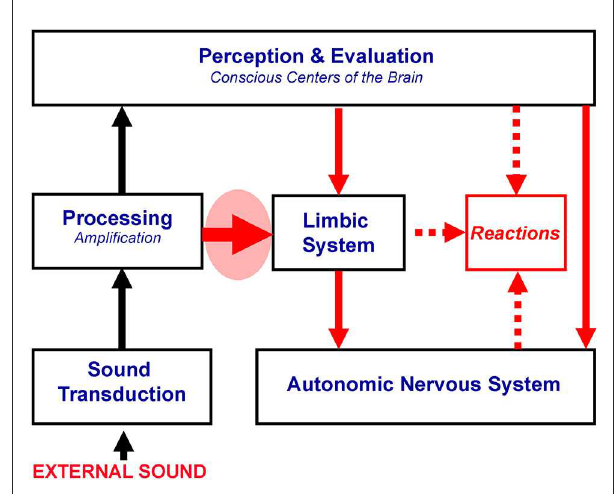
FIGURE2 Proposed mechanisms of misophonia. The thick red arrow in the red oval marks the functional linking of the subconscious part of the auditory system with the limbic and autonomic nervous systems, postulated to be responsible for misophonia. All systems in the brain could be working within the norm. Other symbols are described in Figure